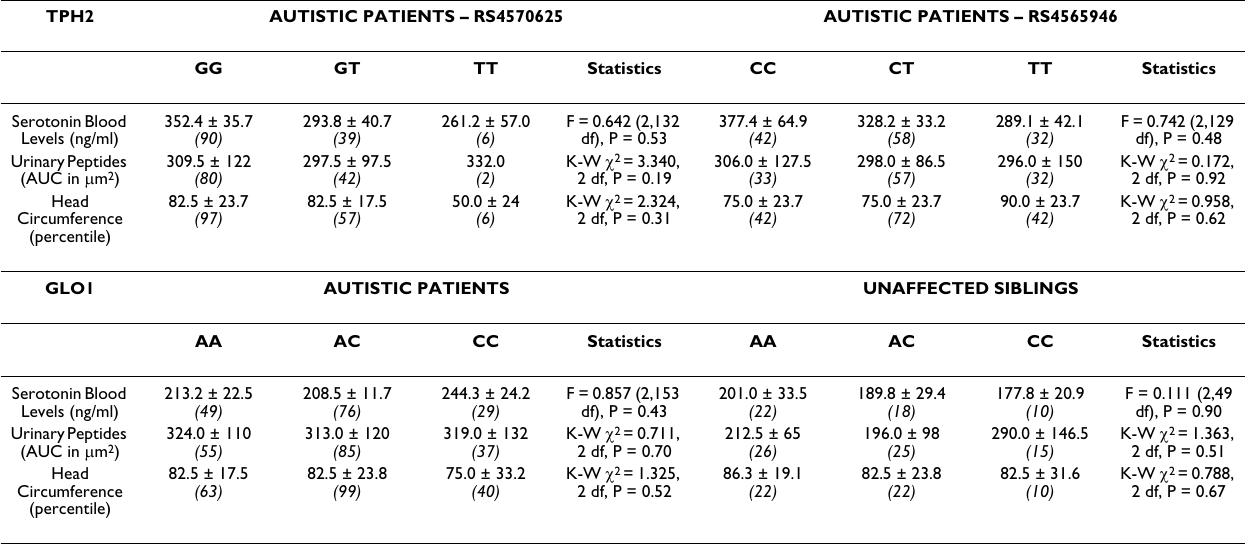
* Data are expressed as mean ± S.E.M. for serotonin blood levels, and median ± semi-interquartilic range for amounts of urinary peptides and head circumference; 2-tail P-values are reported. Sample sizes are shown in italics; K-W = Kruskal-Wallis non-parametric ANOVA.